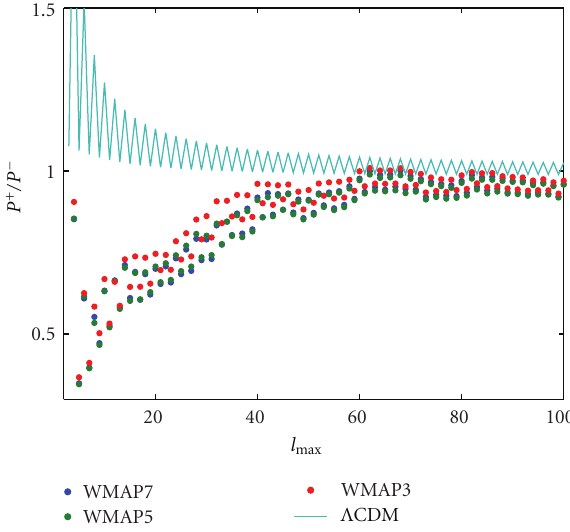
Figure 3: P + /P − of WMAP data and Λ